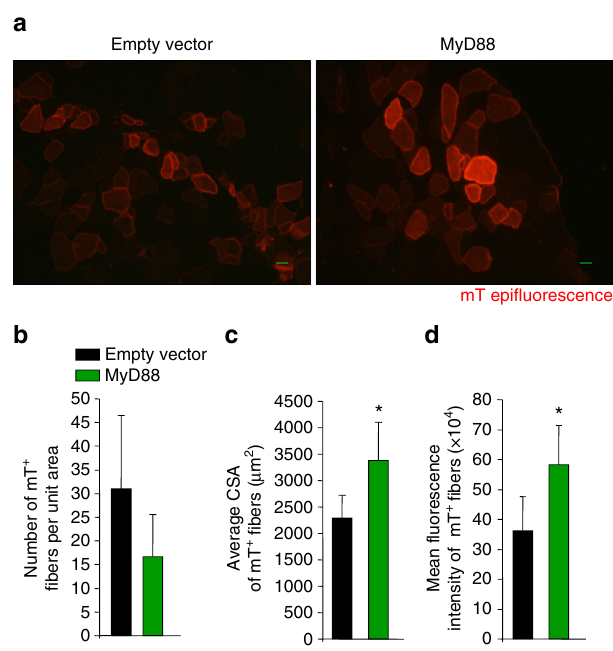
Fig. 7 Overexpression of MyD88 promotes fusion of transplanted myoblasts to injured myo fi bers in vivo. a Primary myoblasts were prepared from hind limb muscle of mTmG mice and transfected with empty vector or vector containing MyD88 cDNA. Cells were then transplanted in TA muscle of WT mice that have been subjected to BaCl 2 -mediated injury for 24 h. After 28 days, the TA muscles were isolated and processed for histological analysis. Representative photomicrographs depicting mT + myo fi bers originating from empty vector or MyD88-transfected transplanted myoblasts. Scale bar: 20 µ m. b Quanti fi cation of number of mT + engrafted myo fi bers per unit area. c Quanti fi cation of average CSA of mT + engrafted myo fi bers in TA muscle sections. d Quanti fi cation of mean fl uorescence intensity of mT + myo fi bers in both groups. N = 4 in